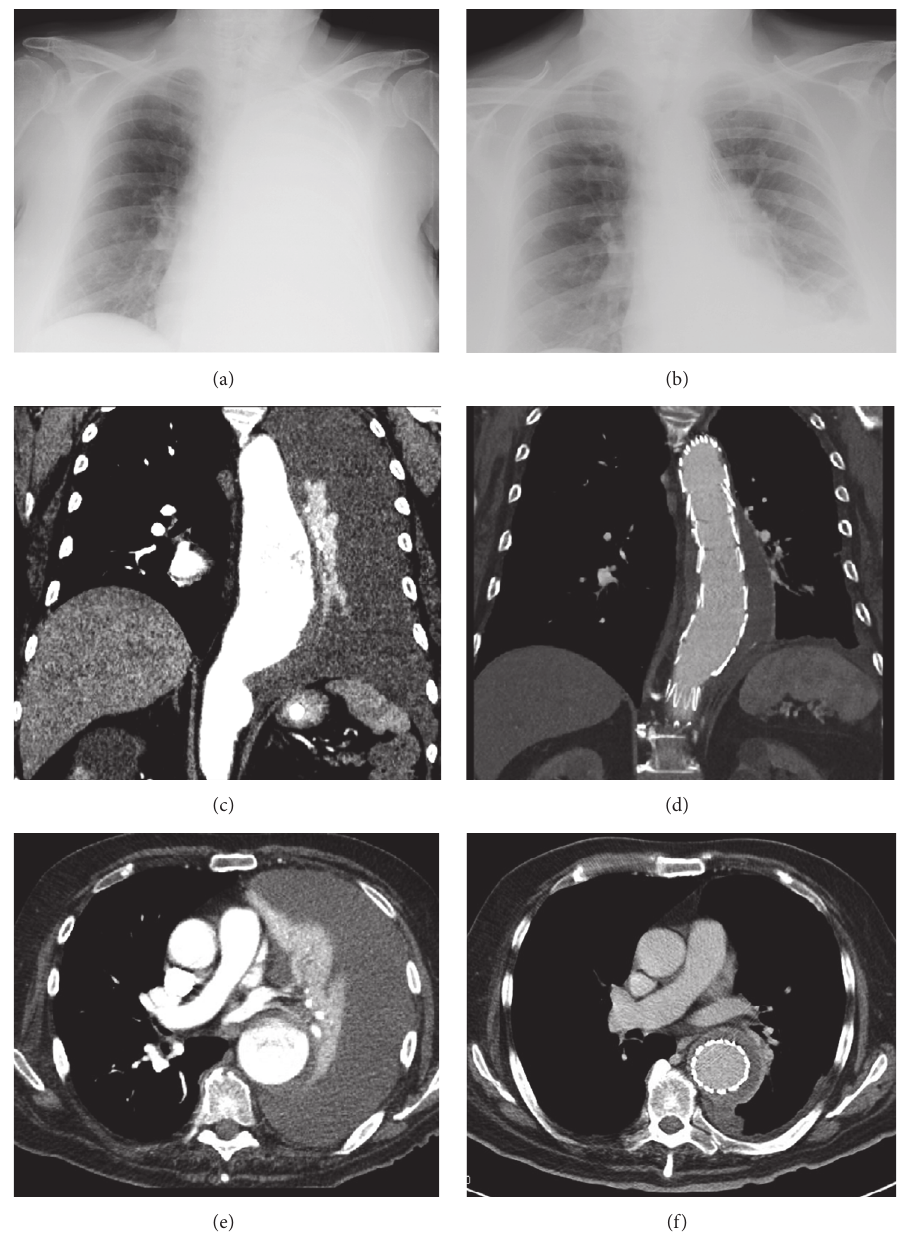
Figure 1: Chest X-ray before (a) and after (b) endovascular repair of thoracic aortic aneurysm (TEVAR) showing the complete opacity of the left lung field due to aneurysm rupture within the pleura (a) and the complete resolution after blood drainage (b). CT-scan before (c and e) and after (d and f) endovascular repair of thoracic aortic aneurysm by TEVAR.